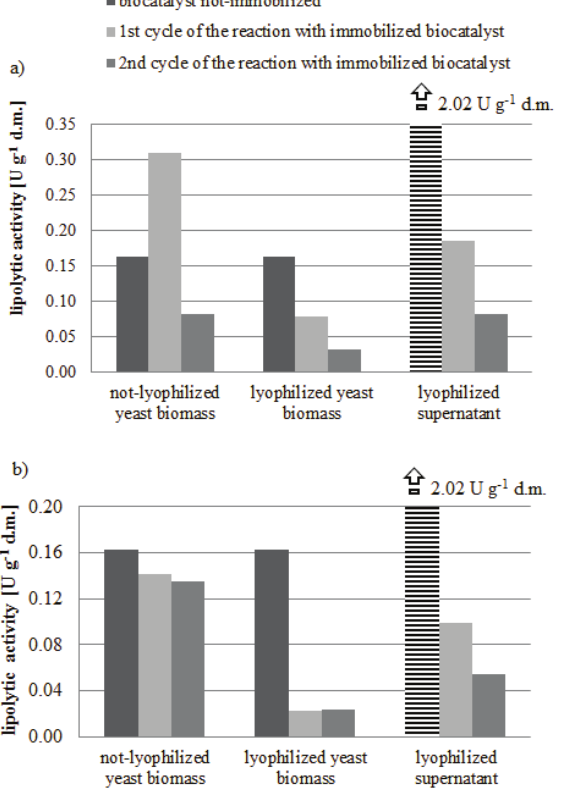
Fig. 6 Fig. 6 – Comparison of the activity of immobilized biocata- lysts in alginate (a) and gelatin (b), in subsequent reactions. Activity of the free supernatant translated from U mL –1 on U g –1 d.m. taking into account the percentage of dry matter equal to 2.7